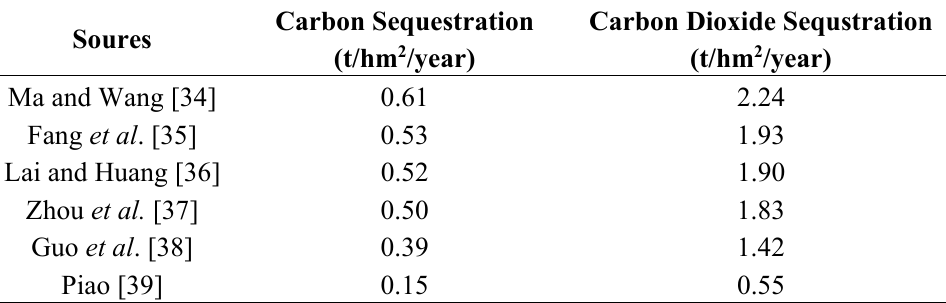
Table 1. Sequestration coefficient of forests in